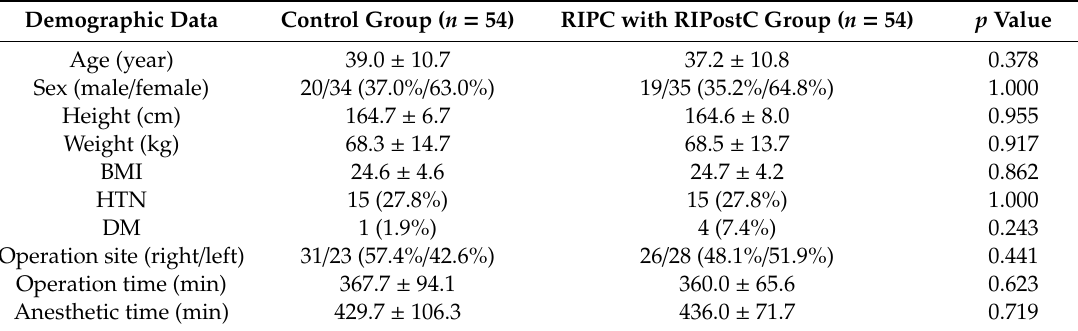
Table 2. Duration of hospital stay and postanastomosis MCA velocity.